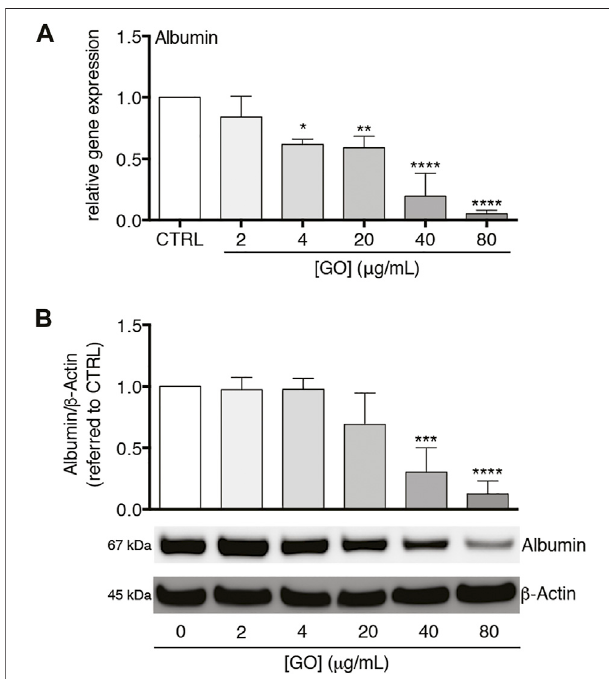
FIGURE 6 | Effects of sub-lethal GO doses on Albumin gene expression and translation in upcyte ® hepatocytes. (A) Relative gene expression of Albumin in GO-treated cells versus untreated cells (indicated as CTRL). Results are expressed as means ± SD values of three independent experiments. The symbols “ * ” , “ ** ” and “ **** ” refer to p = 0.0155, p = 0.0046 and p < 0.0001, respectively, calculated versus CTRL (ordinary one-way ANOVA). (B) Intracellular Albumin level in GO-treated cells in comparison to CTRL,assessedbywesternblot.Densitometricanalysisofthreeblotsderived from independent experiments (means ± SD; upper panel) and a representative blot (lower panels) are reported. β -Actin was used as the internal control to normalize densitometric values of all culture conditions. The symbols “ *** ” and “ **** ” refer to p = 0.0004 and p < 0.0001, respectively, calculated versus CTRL (ordinary one-way